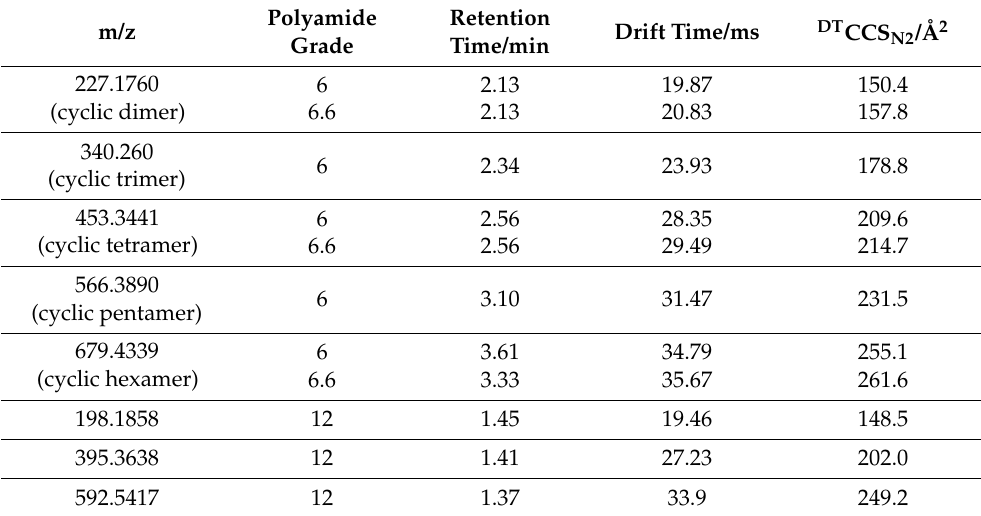
Table 3. Results of the IM-QTOF measurements for the different marker compounds of the polyamide grades. Polyamide Retention Drift Time/ms DT CCS N2 /Å 2 m/z Grade Time/min 227.1760 6 (cyclic dimer)